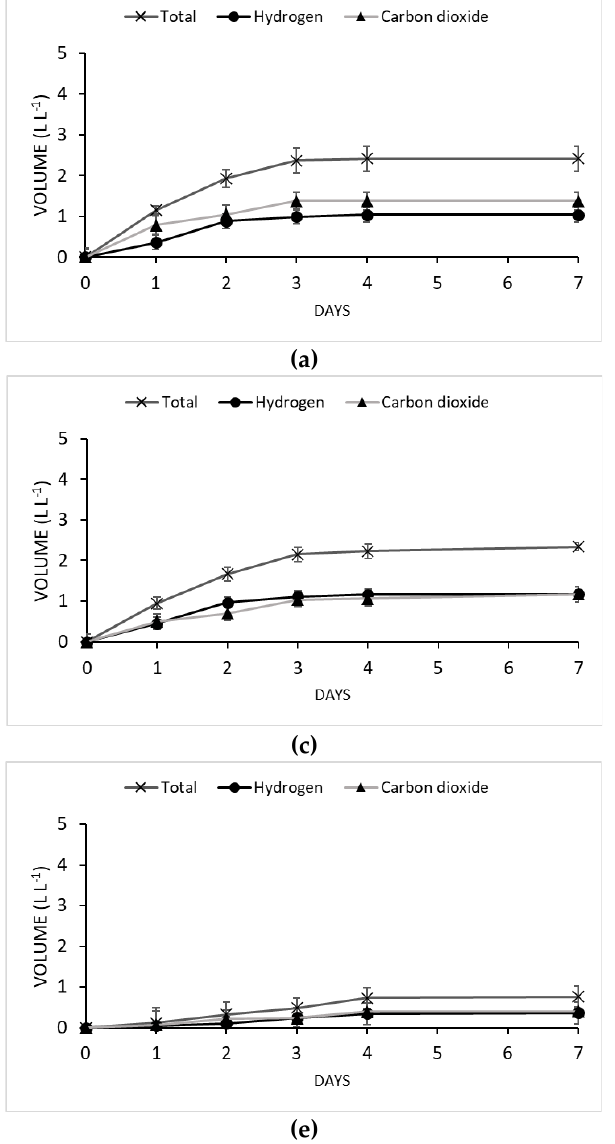
Figure 2. Total biogas, hydrogen and carbon dioxide cumulative production for SET OMW ( a , c , e ) and SET CW ( b , d , f ). ( a , b ): F/M = 1; ( c ) and ( d ): F/M = 2.5; ( e , f ): F/M = Table 3. Results of SET OMW and SET CW.